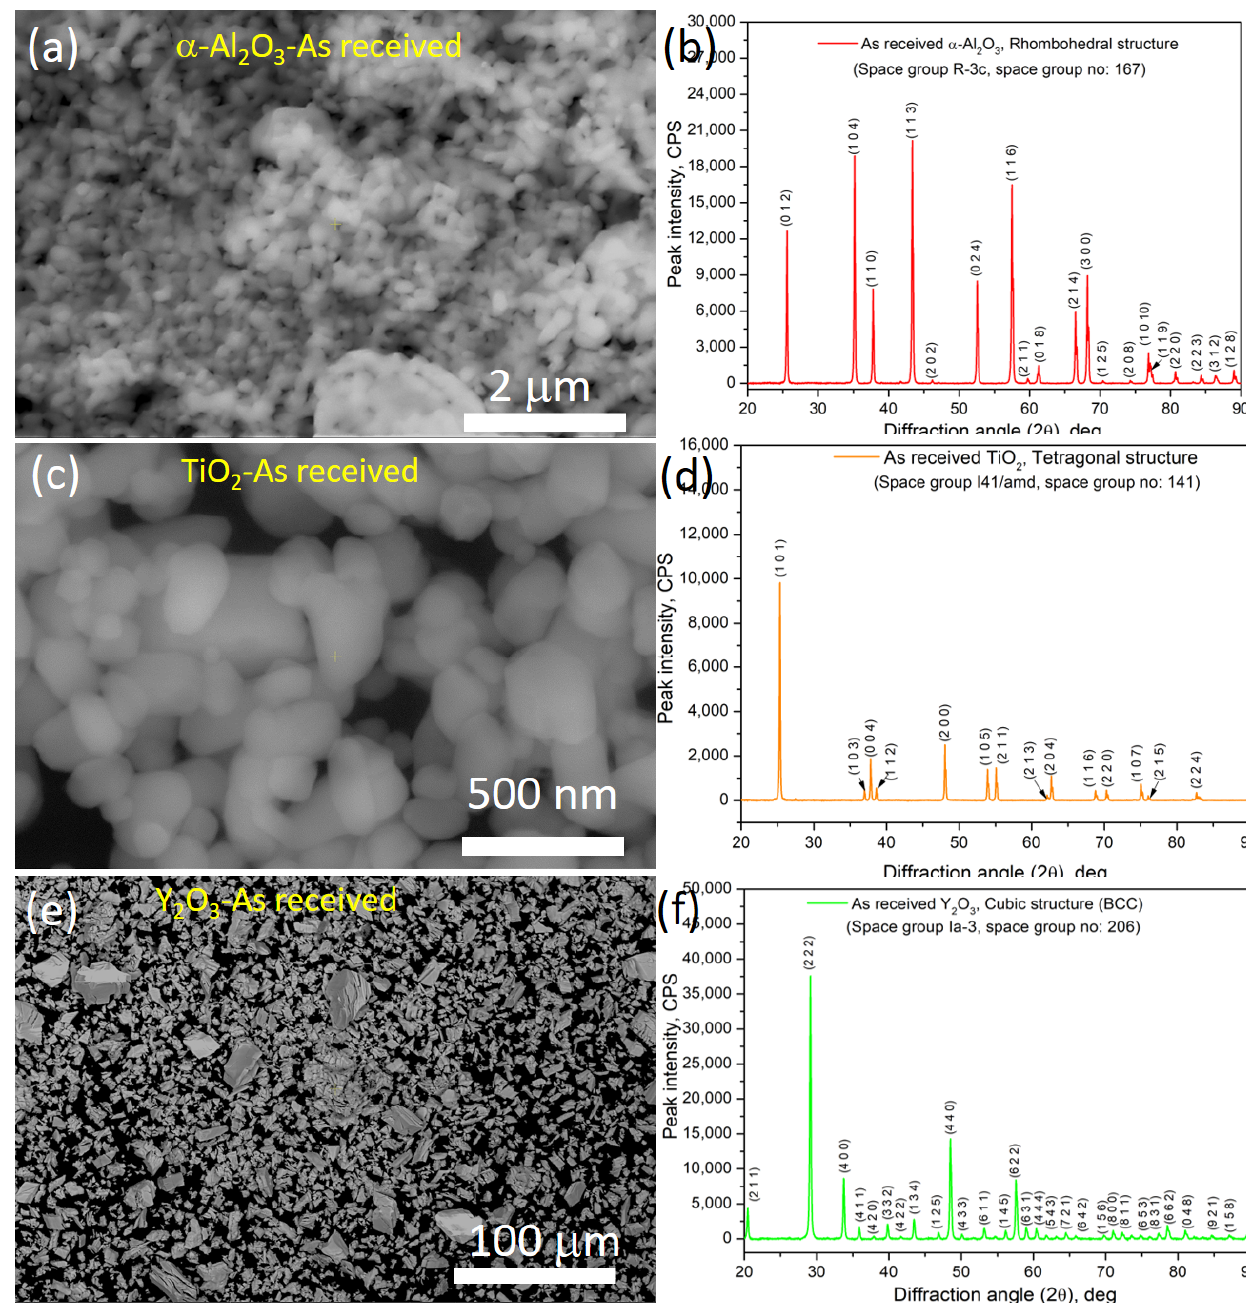
Figure 4. HRSEM powder surface morphology ( left ) and XRD peak profile analyses ( right ) of as-received reinforcements: ( a , b ) α -Al 2 O 3 ; ( c , d ) TiO 2 ; and ( e , f ) Y 2 O 3